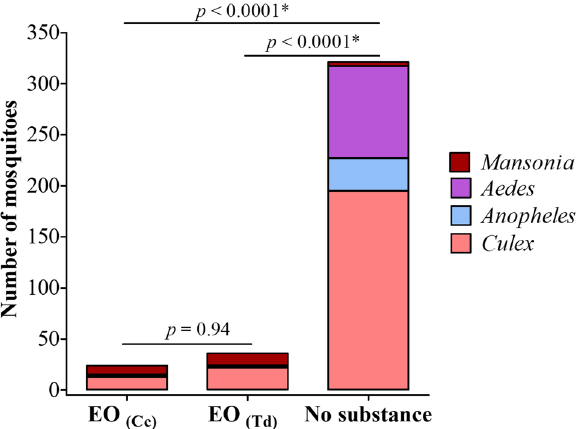
Figure 4. Entomofauna captured in the different groups evaluated. EO (Cc) : Essential oil of C. citratus (positive control); EO (Td) : Essential oil of T. diversifolia ; Pearson’s independence chi-square test was used to compare the groups; *statistically significant at p <